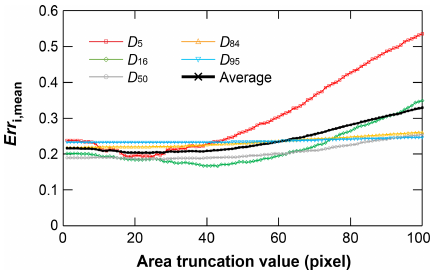
Figure 9. Prediction error versus area truncation value of smallest detectable